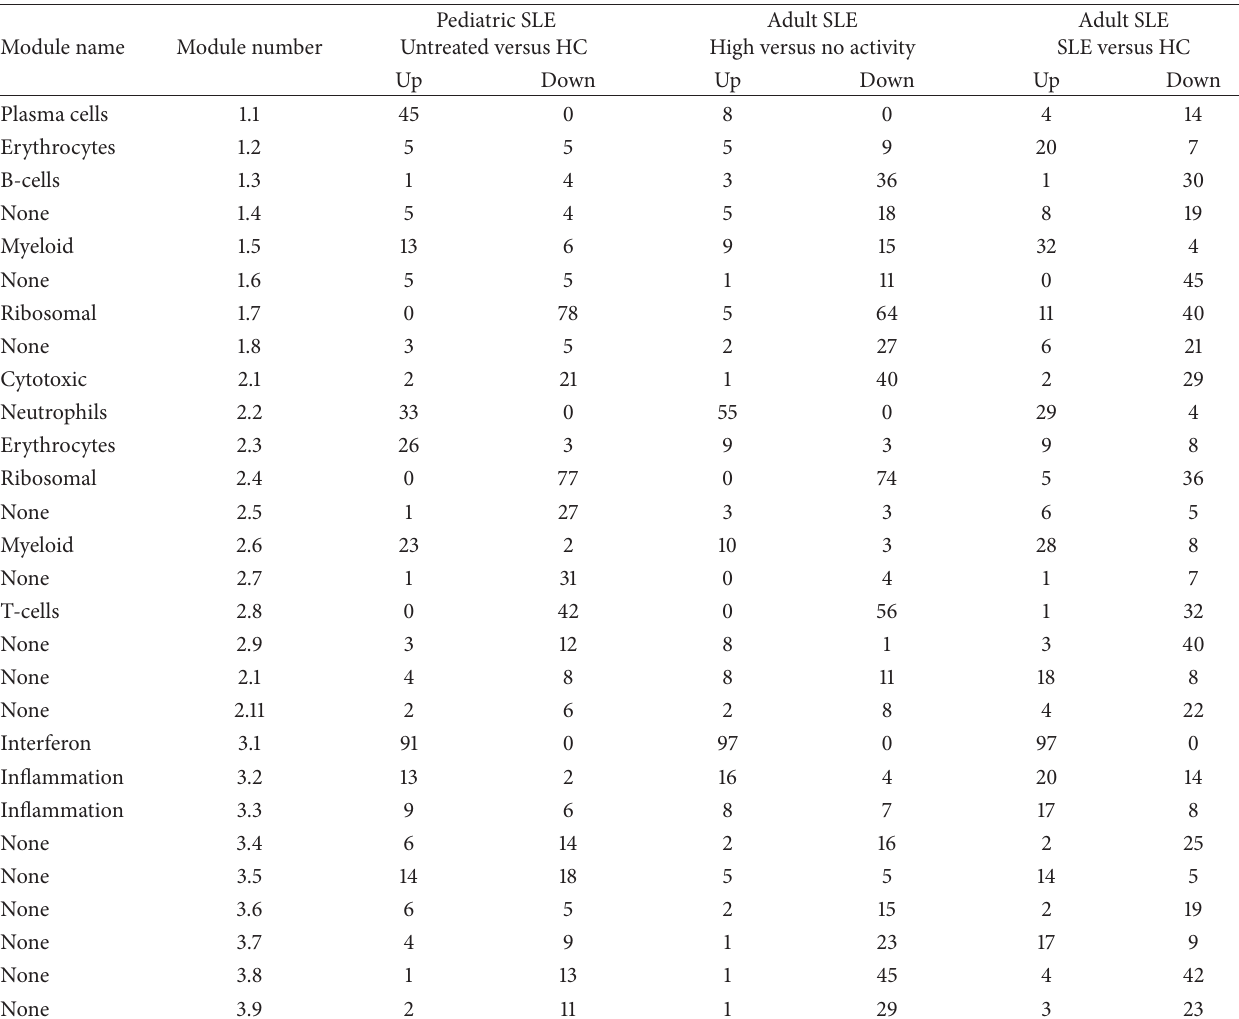
Table 3: Module name and number as described in [12]. The “pediatric SLE” column is reproduced from GSE11909. The numbers shown are the percentage of genes from the module that have significant differential gene expression (DGE). Thus, the first row is interpreted as follows: 45% of the genes in Module 1.1 have significant DGE and are increased in expression. The second column, “Adult SLE, High versus No Activity,” is a DGE analysis between lupus patients with high disease activity and lupus patients with no activity. The third column, “Adult SLE versus HC” is a DGE analysis between a cohort of lupus patients with average disease activity and healthy